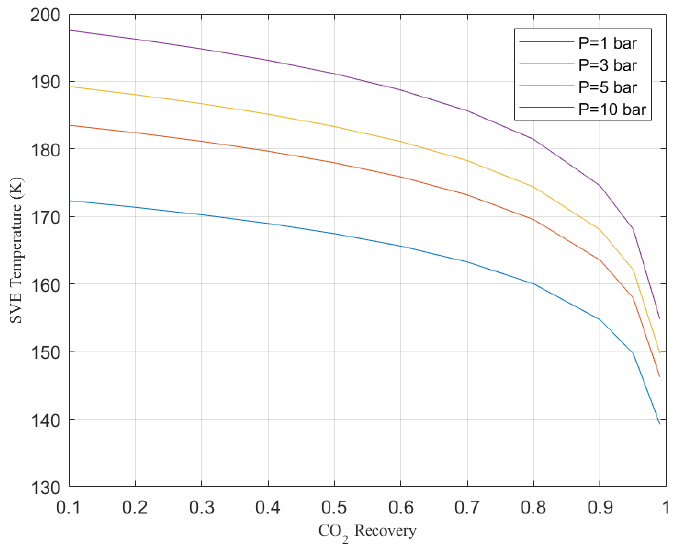
Figure 6. SVE temperature for different CO 2 recovery values for different flue gas pressures.